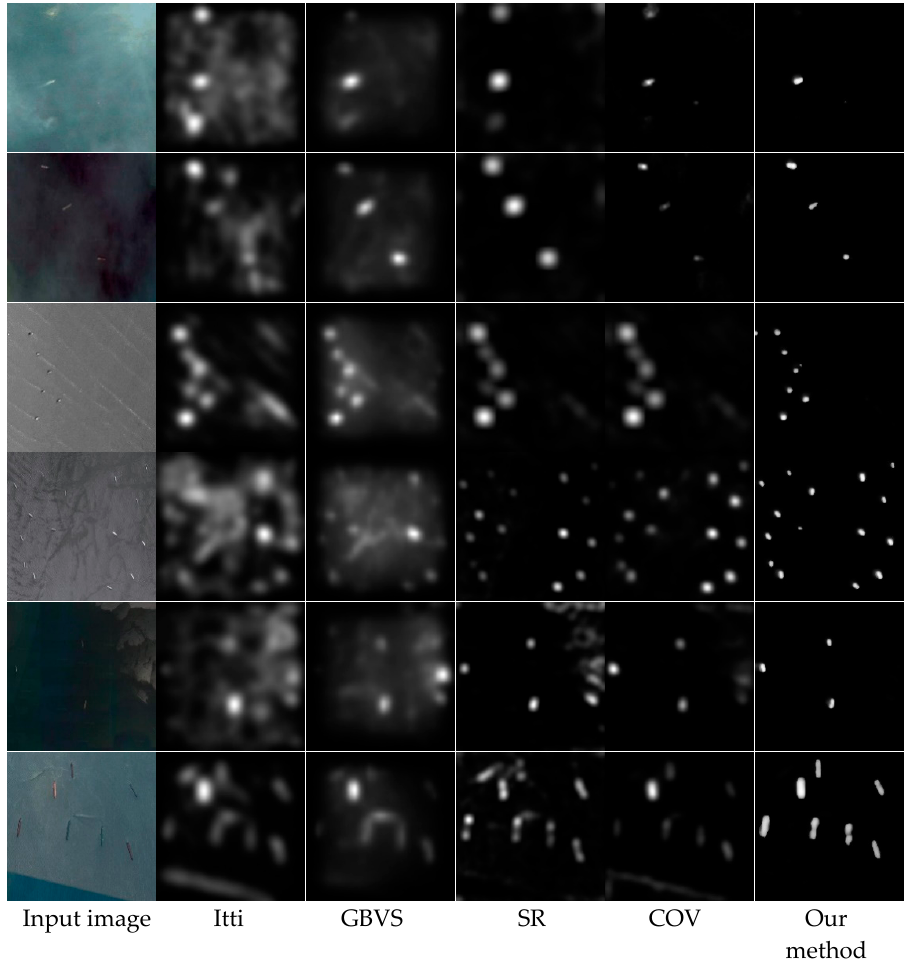
Figure 8. Examples of saliency maps with comparison to the 4 state-of-the-art methods. From left to right: input image, Itti[9], GBVS(Graph-Based Visual saliency)[10], SR(Spectral-Residual)[13], COV(Covariance saliency)[23], and our method. Our method outperforms other typical methods visually.